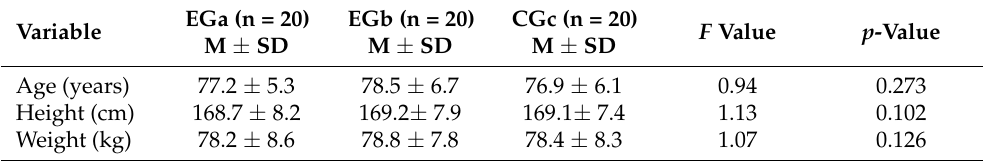
Table 1. Basic participant information.